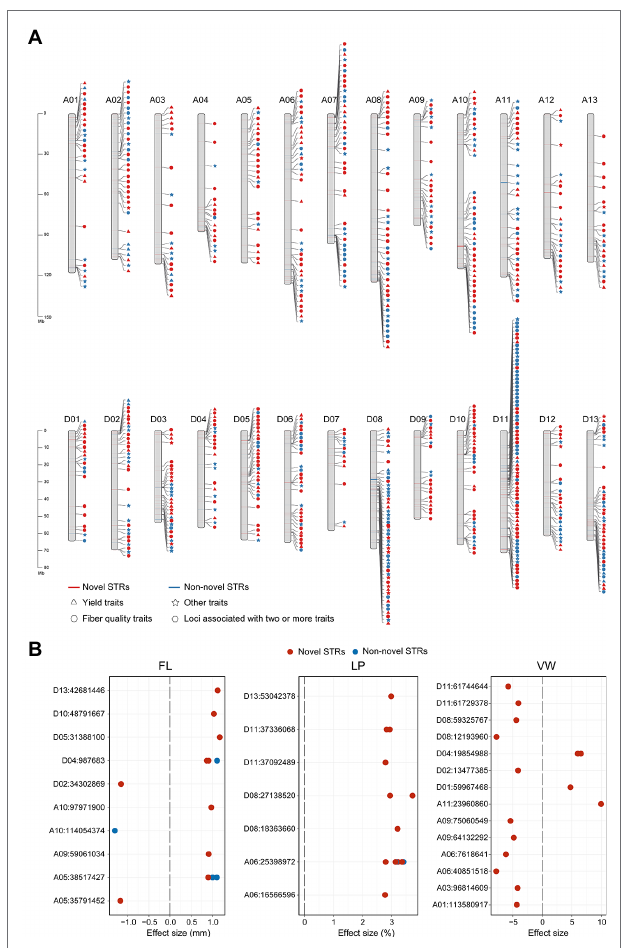
FIGURE 3 | Distribution of 824 STR loci associated with agronomic traits. (A) Chromosomal distribution of 824 STR loci associated with agronomic traits. Red indicates novel STR loci, and blue those supported by previous SNP-based GWAS (non-novel STRs). Yield traits are BW, FWBP, LI, LP, SI, and BN (triangles). Fiber quality traits are FE, FL, FM, FS, LU, MAT, SCI, and FU (circles). Other traits are PH, VW, FD, and PP (stars). Hexagons represent STR loci associated with two or more traits (yield, quality, and other traits). A1-D13 represent the 26 allotetraploid cotton chromosomes. (B) Effect sizes of STRs associated with FL, LP, and VW. Red circles represent novel STR loci and blue circles non-novel STRs. Each dot indicates an